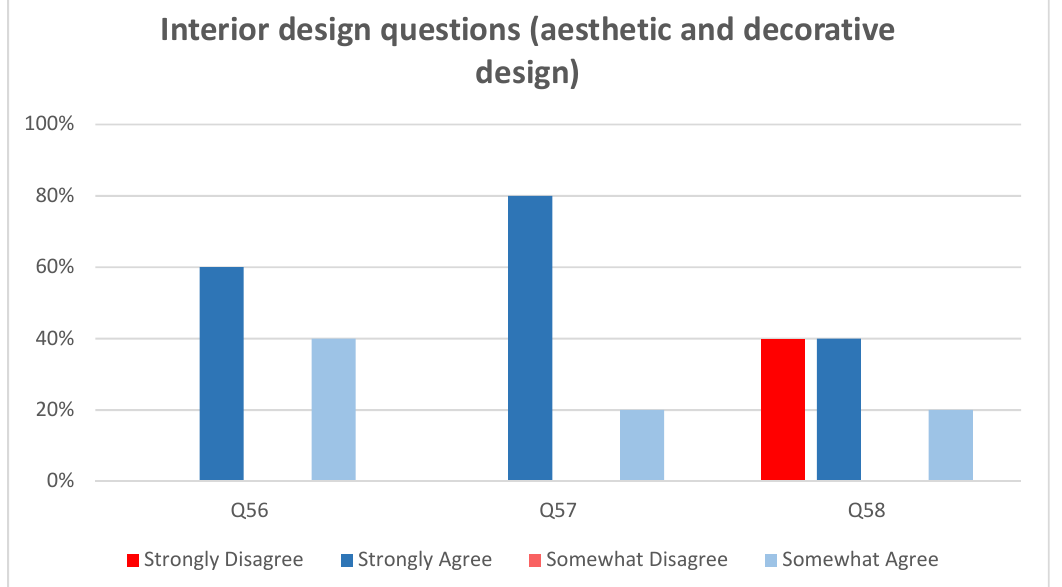
Figure 15. Results for the questions on aesthetics and decorations .